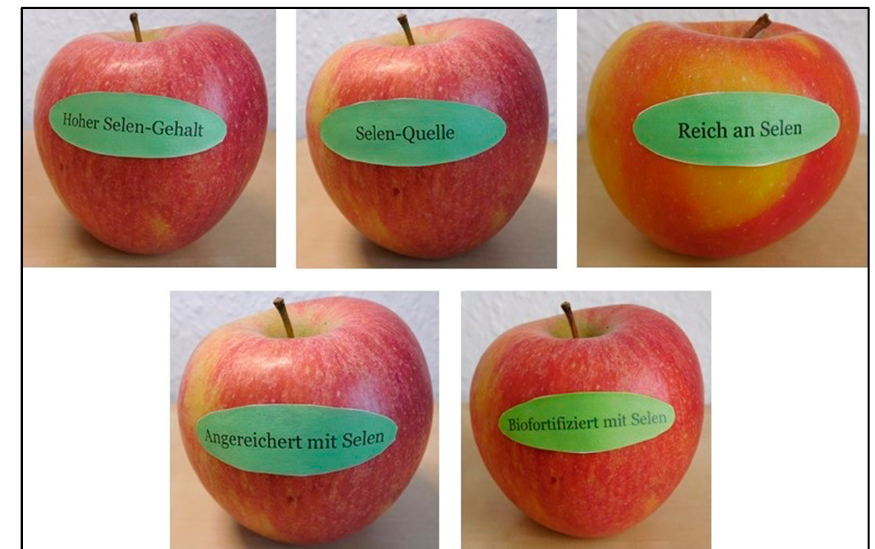
Figure A1. Visual stimulus for Se nutrition claims for apples (translated nutrition claims: High Se content, Source of Se, Rich in Se, Enriched with Se, Biofortified with Se).